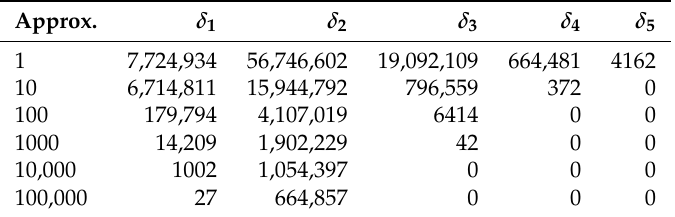
Table 4. Number of skipped columns of the coboundary matrix for the Blue Brain Project graph with respect to different values of the Approximate parameter. The approximation accuracy of β i depends theoretically on the number of columns skipped in the coboundary matrices for δ i − 1 and δ i . Approx. δ